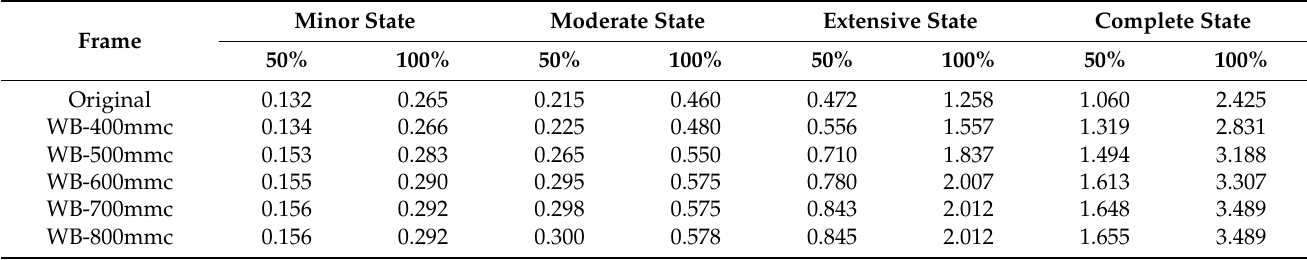
Table 7. The PGA (g) accordance to the probability of 50% and 100% of each state for WB-CFRP